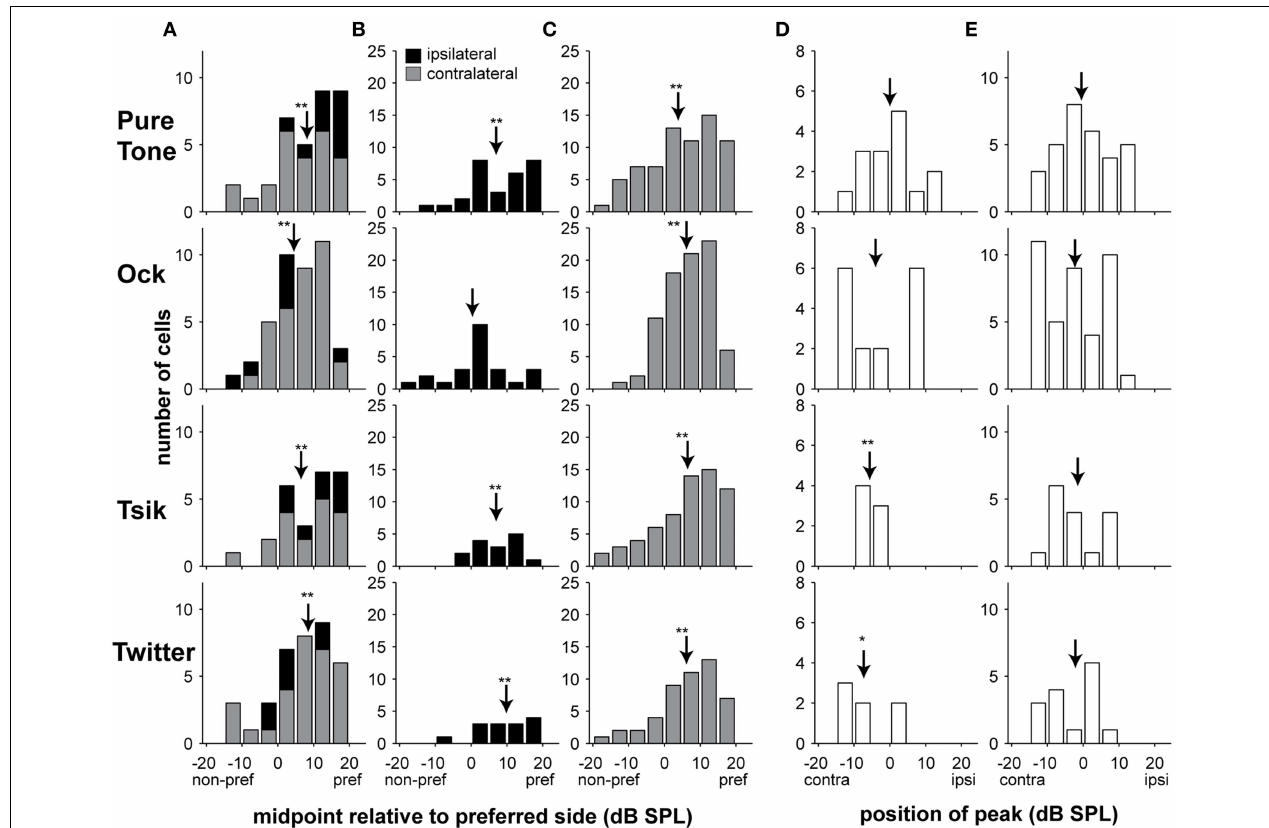
all three intensities are significantly (monotonically) sensitive. Columns (D,E) show the positions of the peaks for cells that were better described by peaked ILD-response functions; positive values indicate louder in ipsilateral ear, and negative values indicate louder in the contralateral ear. In Column (D) , as per Column (A) , only results from the ABL opt for peak-tuned cells are included. In Column (E) , all significant responses are included. Shading of bars indicates tuning type; arrows in all cases indicate the mean, * p < 0 . 05 , ** p < 0 . 001 . Abbreviations: contra, contralateral; ipsi, ipsilateral; pref, preferred; non-pref,